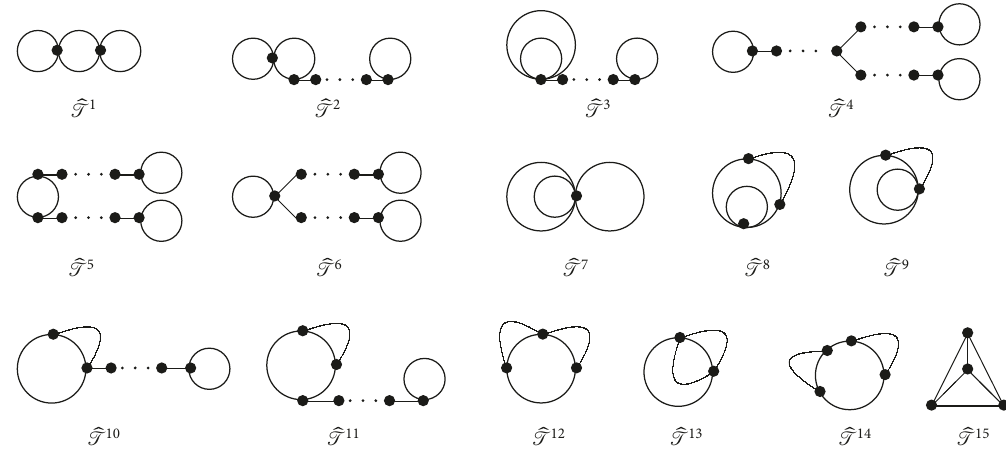
Figure 1: The fifteen types of bases for tricyclic